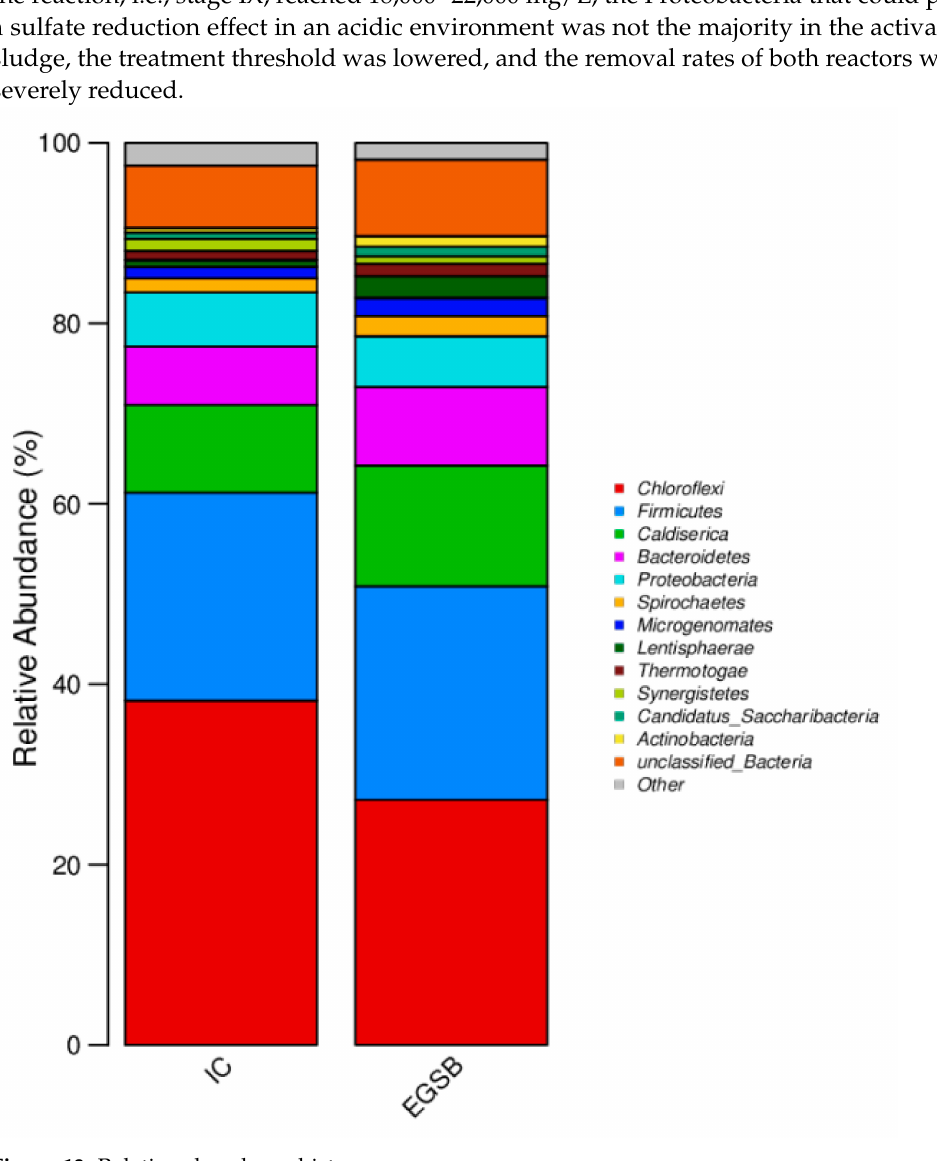
Figure 13. Relative abundance